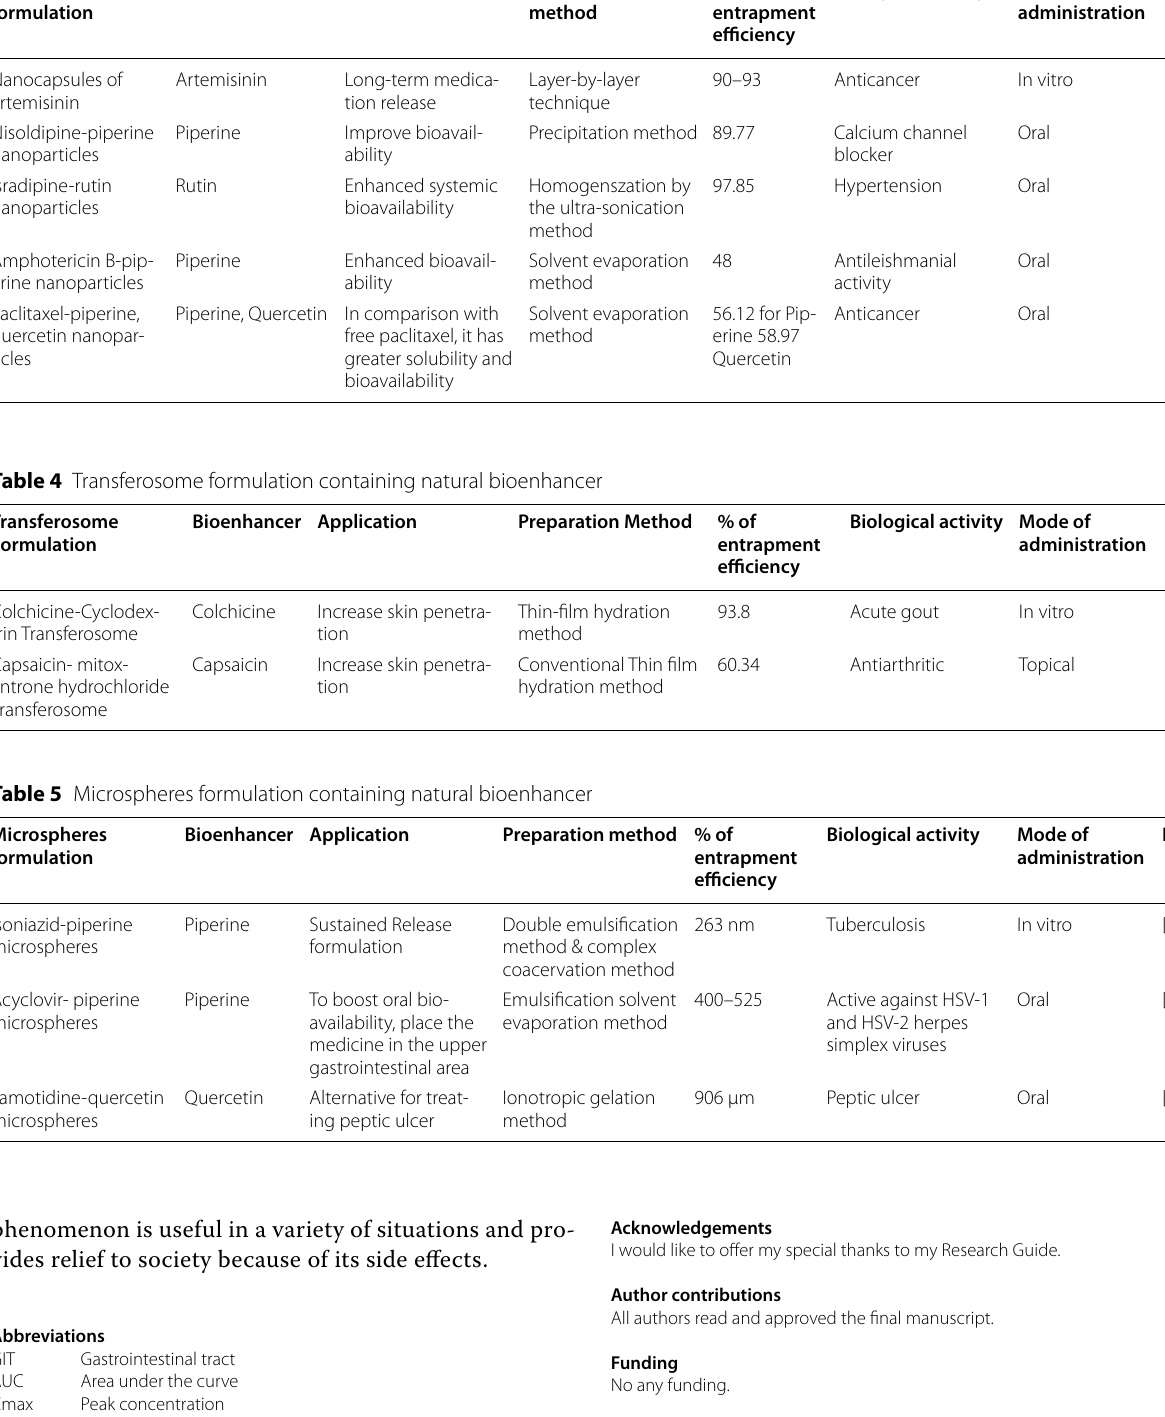
Table 3 Nanoparticle formulation containing natural bioenhancer Nanoparticle formulation